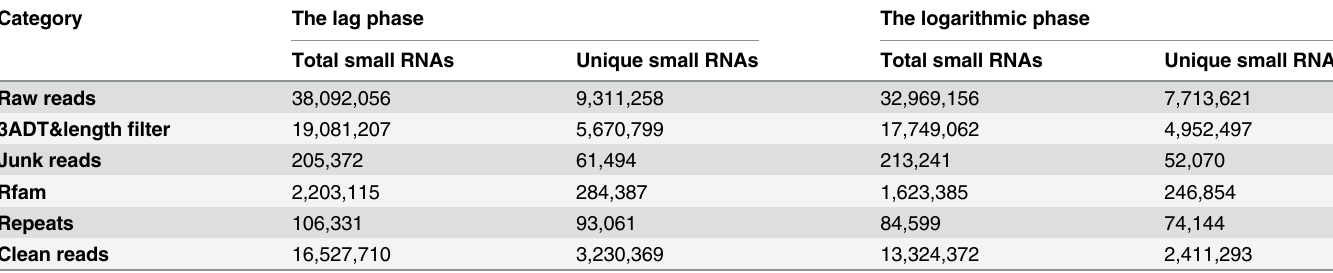
Table 1. Data statistics of small RNAs produced by Illumina deep sequencing.